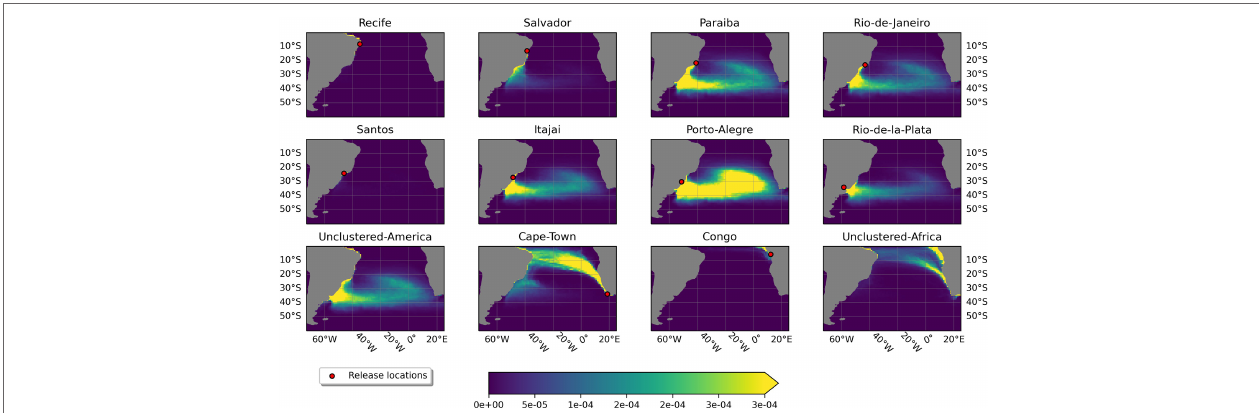
FIGURE 2 | Likelihood maps of the spatially binned p(S loc |R i ) for each cluster. The color scale indicates the probability of finding a plastic particle coming from the cluster, indicated as a red